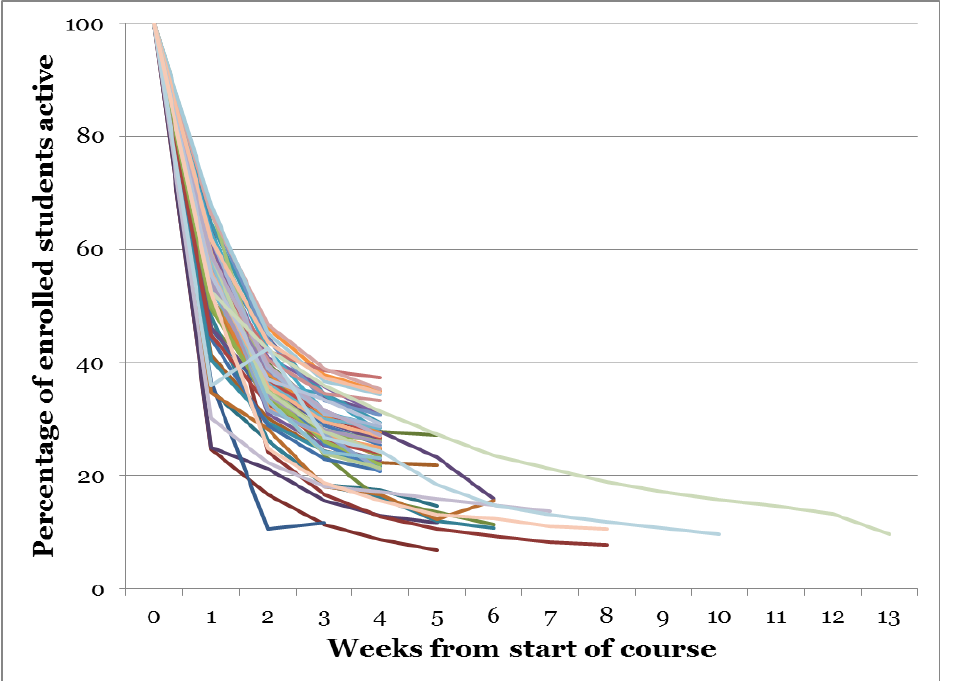
Figure 5 . Proportion of active students (accessing course materials) per week since start of course as a percentage of total enrolment